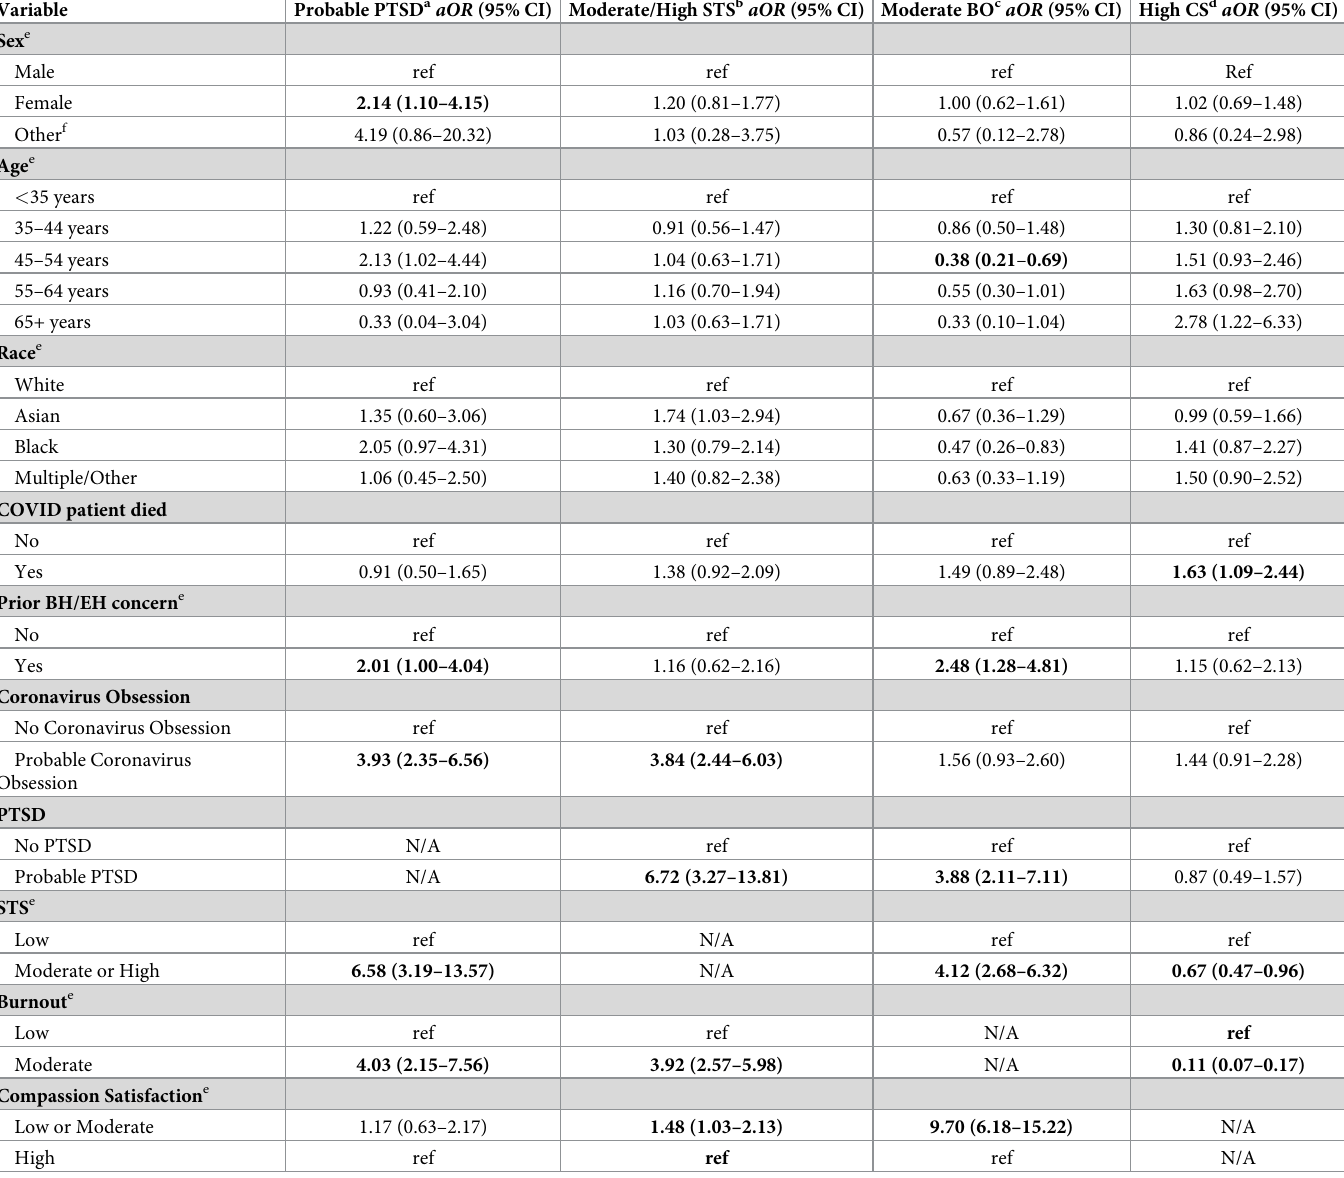
Table 2. Adjusted multivariable logistic regression models for post-traumatic stress disorder (PTSD), secondary traumatic stress (STS), burnout and compassion satisfaction among Lincoln Hospital survey respondents.